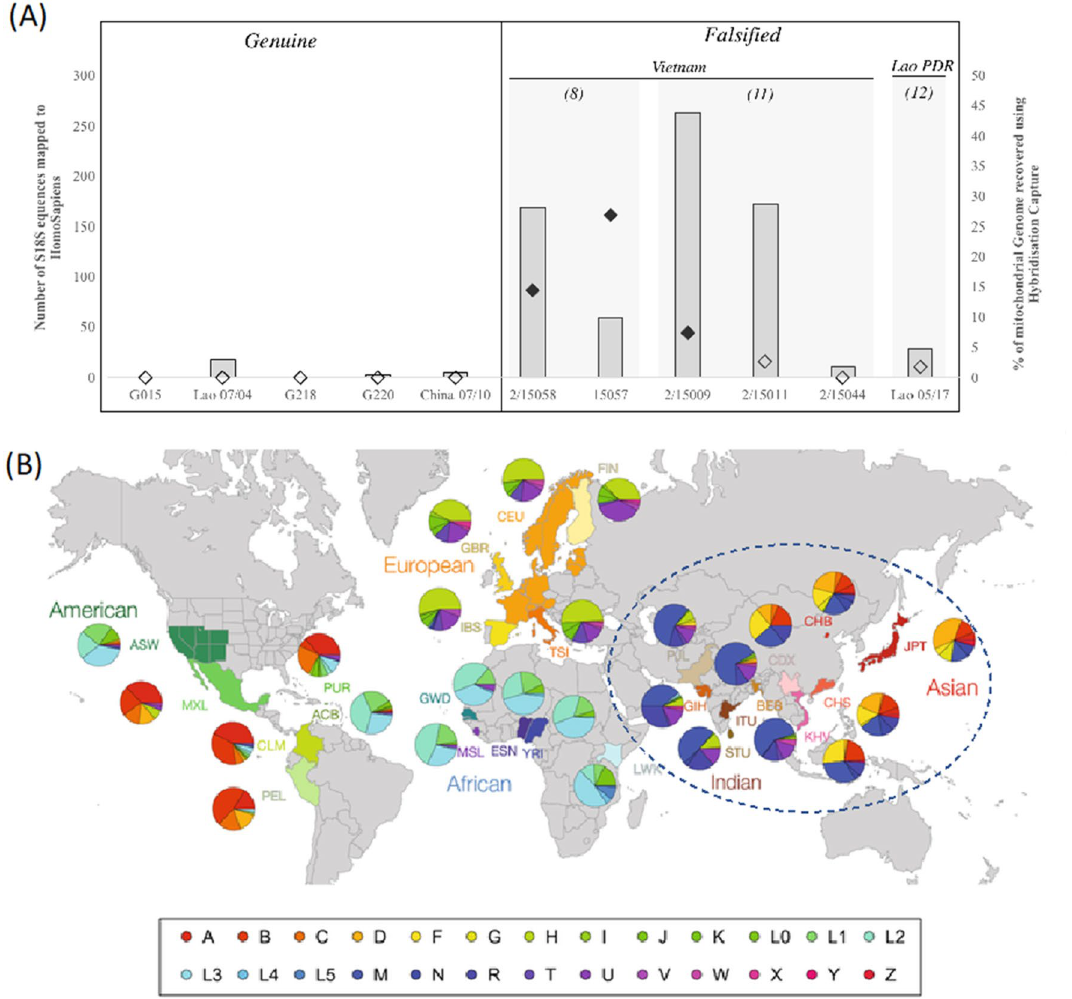
Figure 5. ( A ) Detection of human DNA from tablet extracts using 18S rRNA (as bars) and whole mitochondrial genome hybridization capture analysis (filled diamonds indicate samples where a single source control region sequence (~ 160 bp) was also recovered using PCR). ( B ) The biogeographic ancestry predictions from the mitochondrial control region sequences (blue dotted line) reflected on the frequency of mtDNA subgroups across different geographic populations from the 1000 Genomes Project. The map and haplogroup frequency pie charts have been modified after being reproduced from 40 under the Creative Commons Attribution 4.0 International License (https:// creat iveco mmons. org/ licen ses/ by/4.